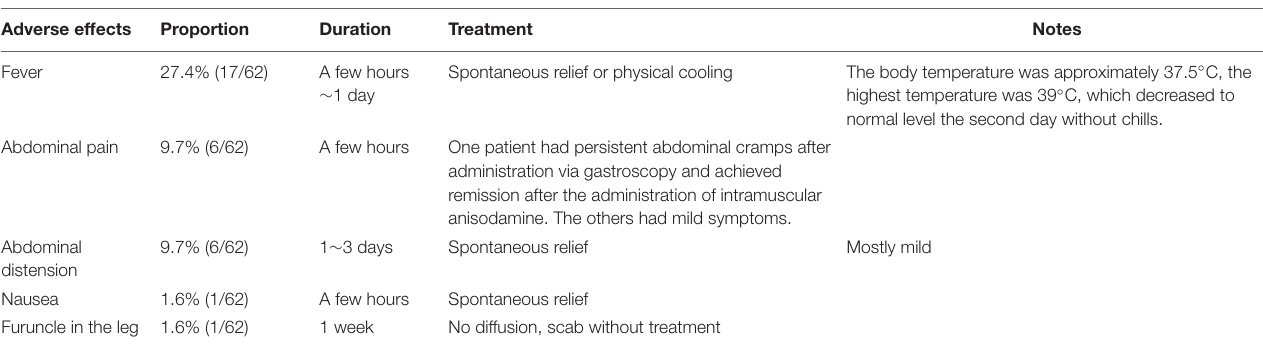
TABLE 4 | Safety assessment of 31 patients with 62